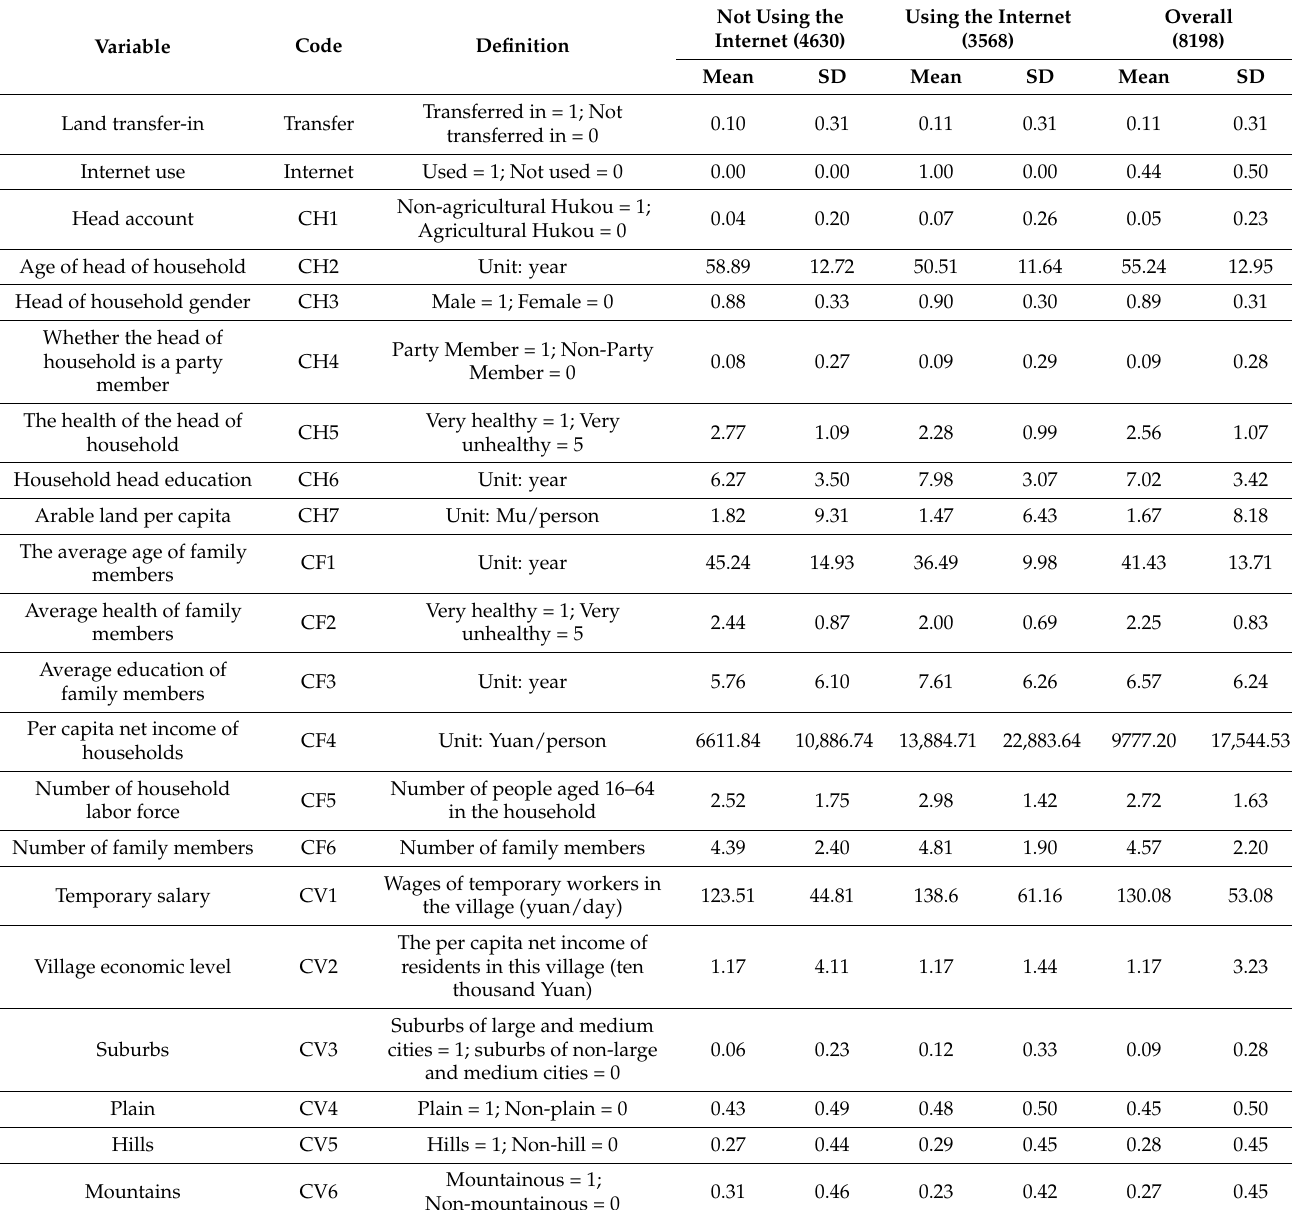
Table 1. Variable settings and descriptive